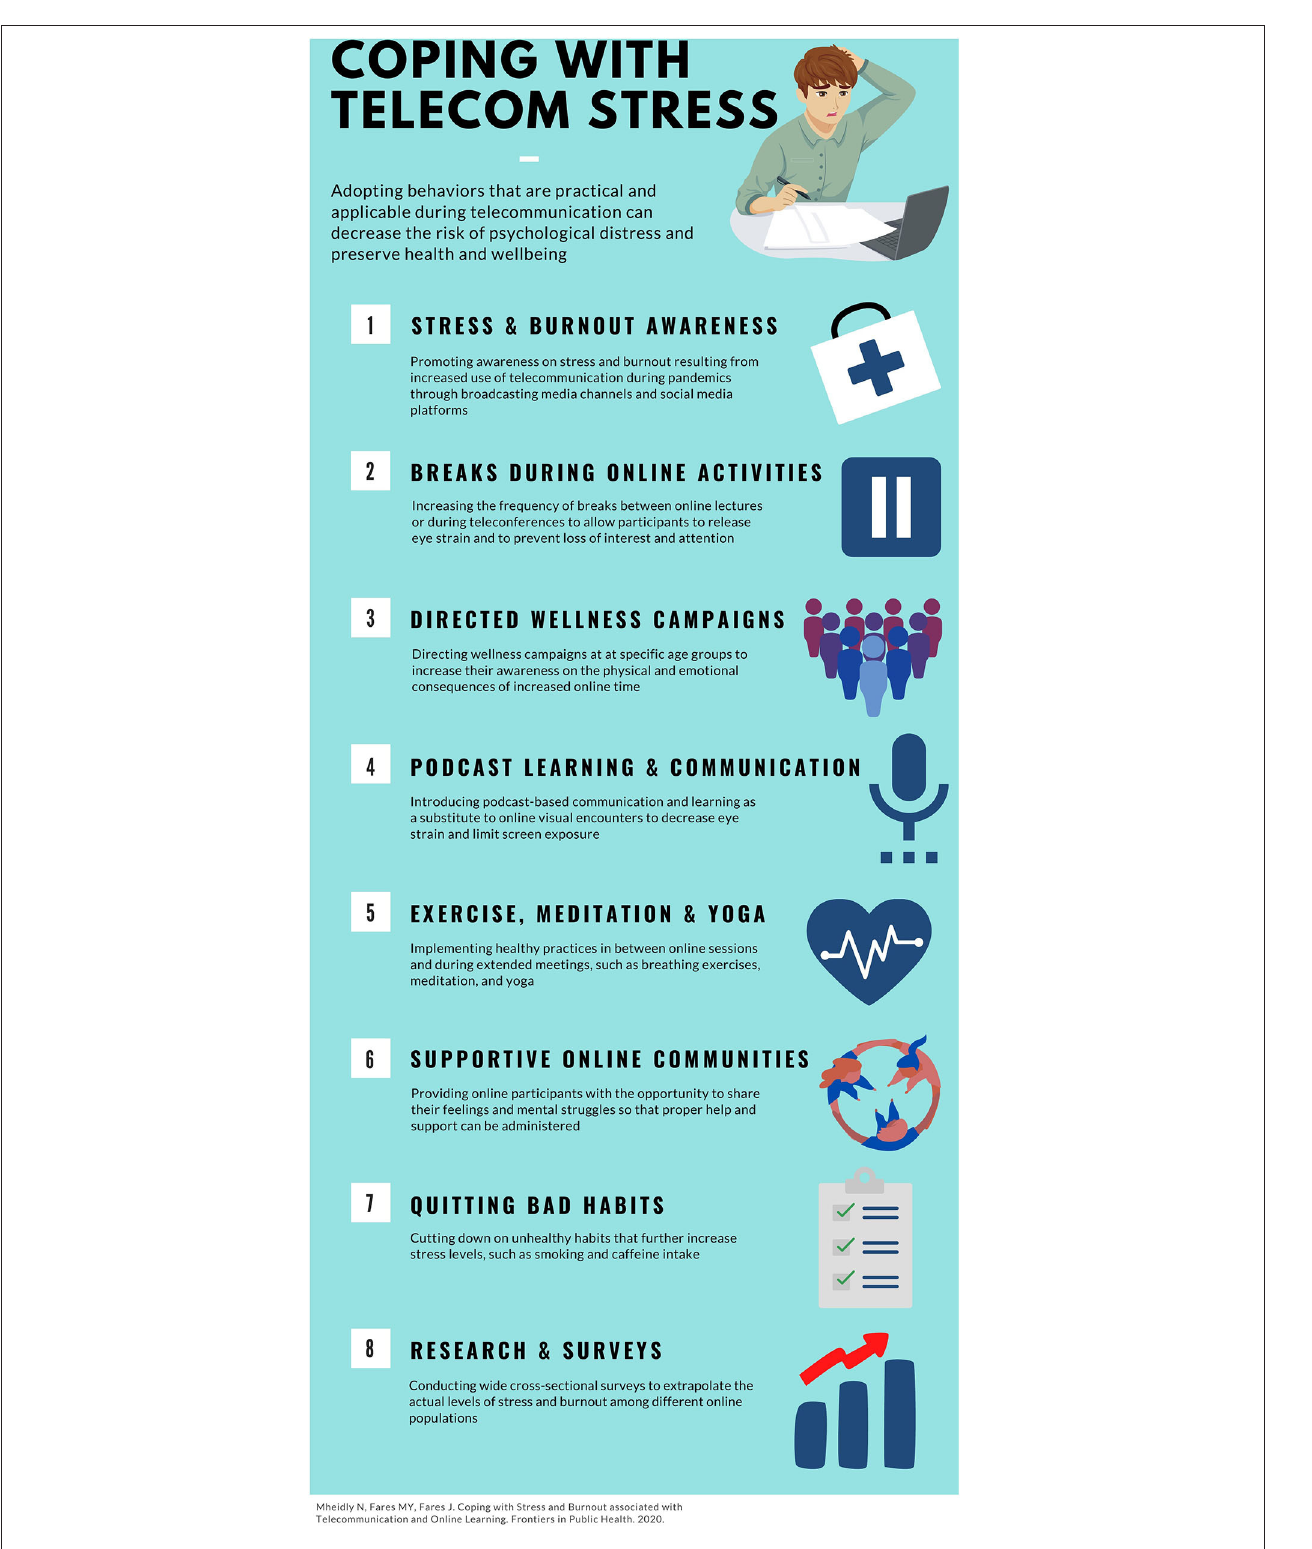
FIGURE 1 | An infographic presenting the coping strategies to be adopted during extended online activities and learning sessions.